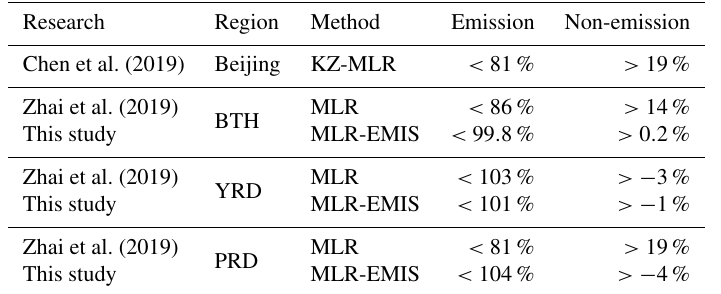
Table 3. Contributions of emissions and non-emissions (including climate and meteorological conditions) to the observed PM 2 . 5 trends in 2013–2018 (2013–2017 for Chen et al., 2019).